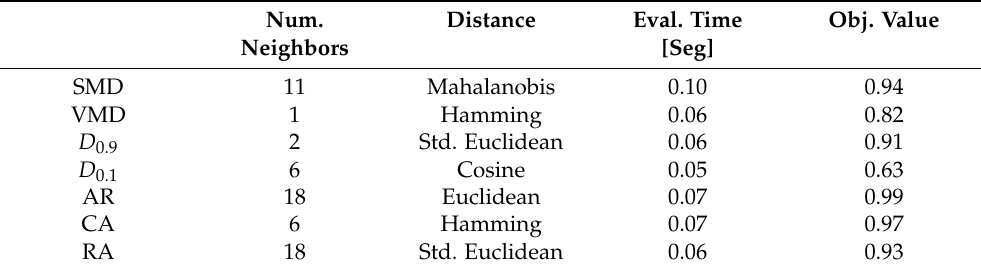
Table 7. k Neighbors of the PPQV soft sensor found using optimization. Num. Distance Eval. Time Obj.